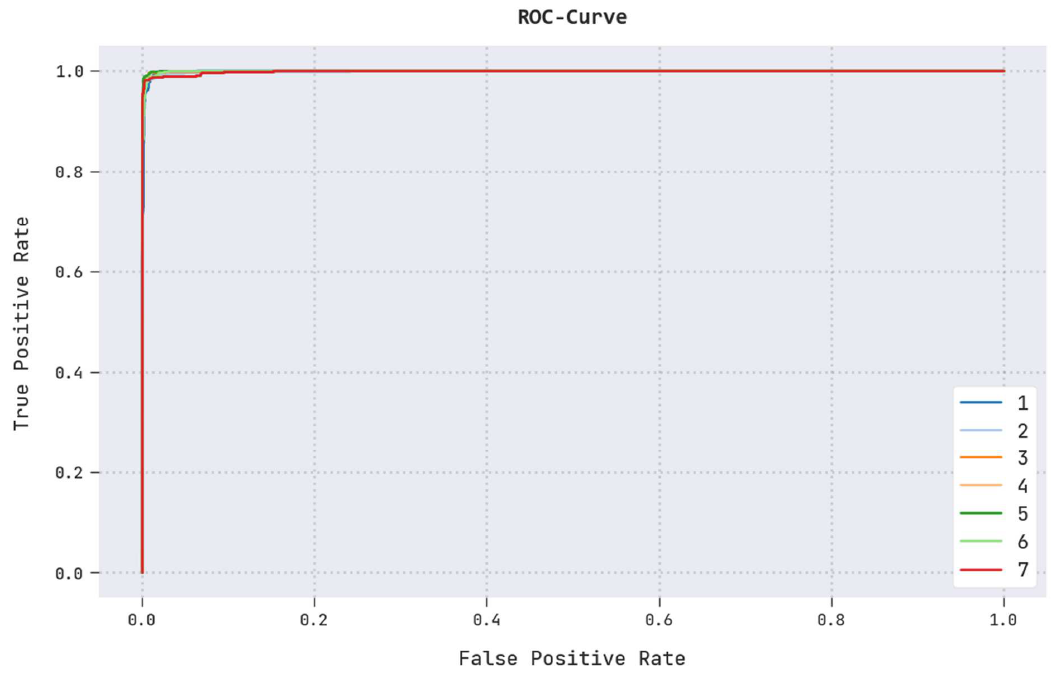
Figure 7. ROC analysis of the CL-DLBIDC approach.